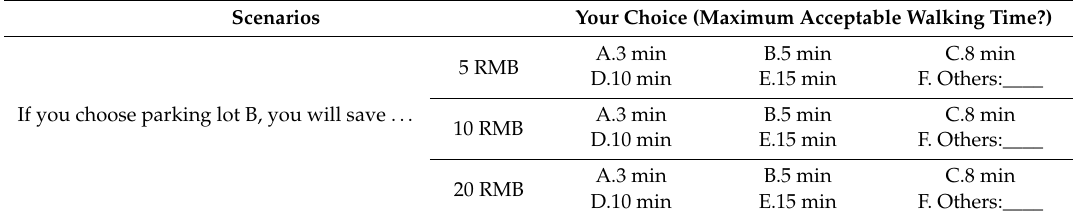
Table 1. Three Scenarios for Testing the Sensitivity of Parking Fee. Scenarios